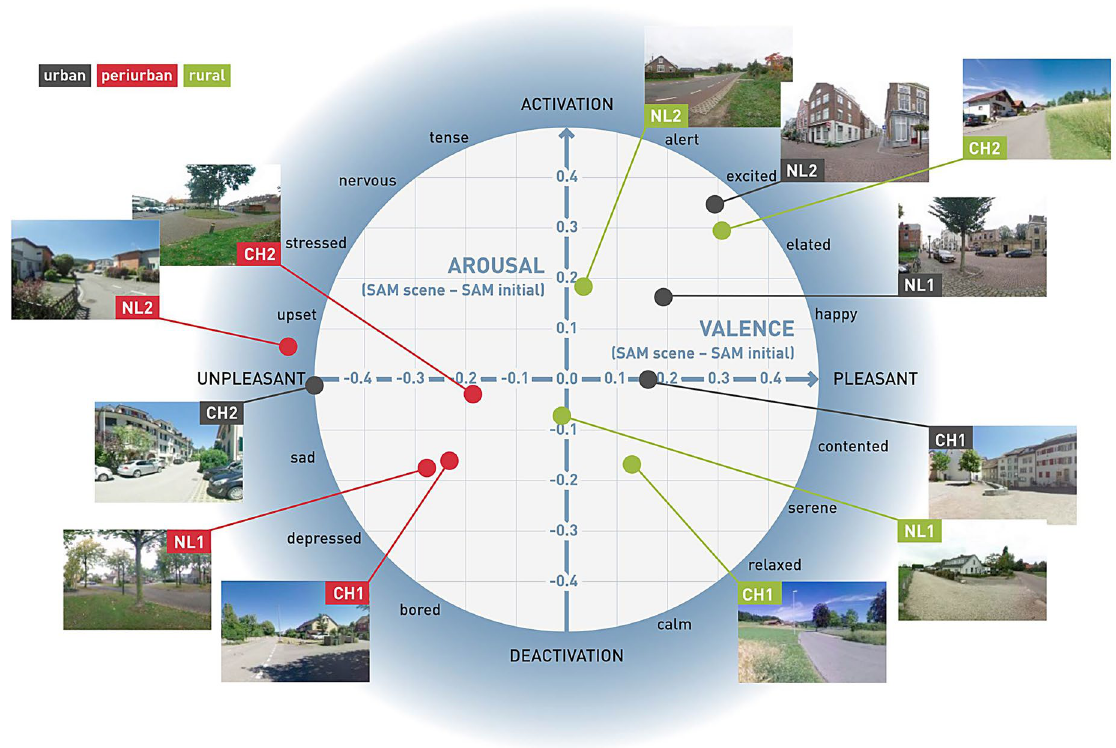
Figure 2. Representation of conscious arousal and valence assessments across participants into Feldman Barett and Russel circumplex model of affective reactions 64 . Arousal and valence measurements are means of the participants’ responses, and were adjusted with the initial status of each participant. The numbers 1 and 2 refer to the two scenes in Switzerland (CH), respectively the Netherlands (NL).